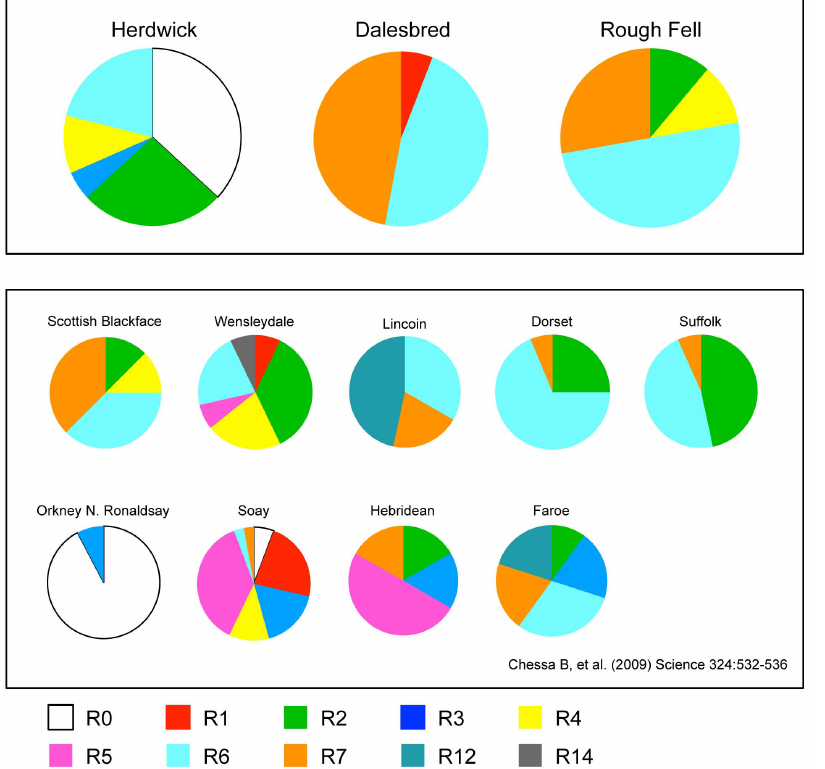
Figure 2. Analysis of retrotypes. The four most common retrovirus events (enJSRV-18, enJSRV-7, enJS5F16, enJSRV-8) were used by Chessa et al [17] to construct a classification scheme based on retrotypes. The pie charts show the relative proportion of retrotypes in each of the three hill breeds in this study. For ease of comparison, the colouring of each retrotype is the same as used in [17], and pie charts of example breeds from [17] are also illustrated in the Figure.